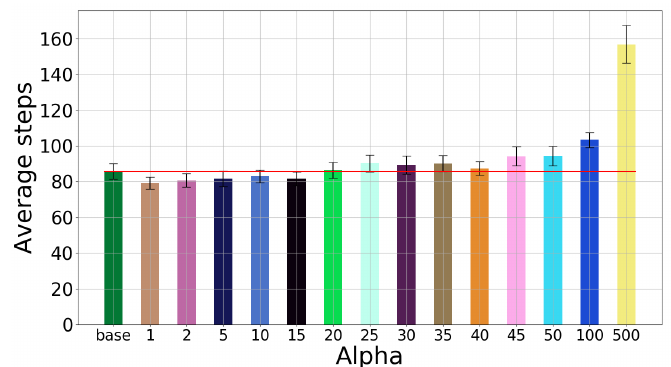
Figure 14. Two-position observations: Number of steps when varying the α parameter.